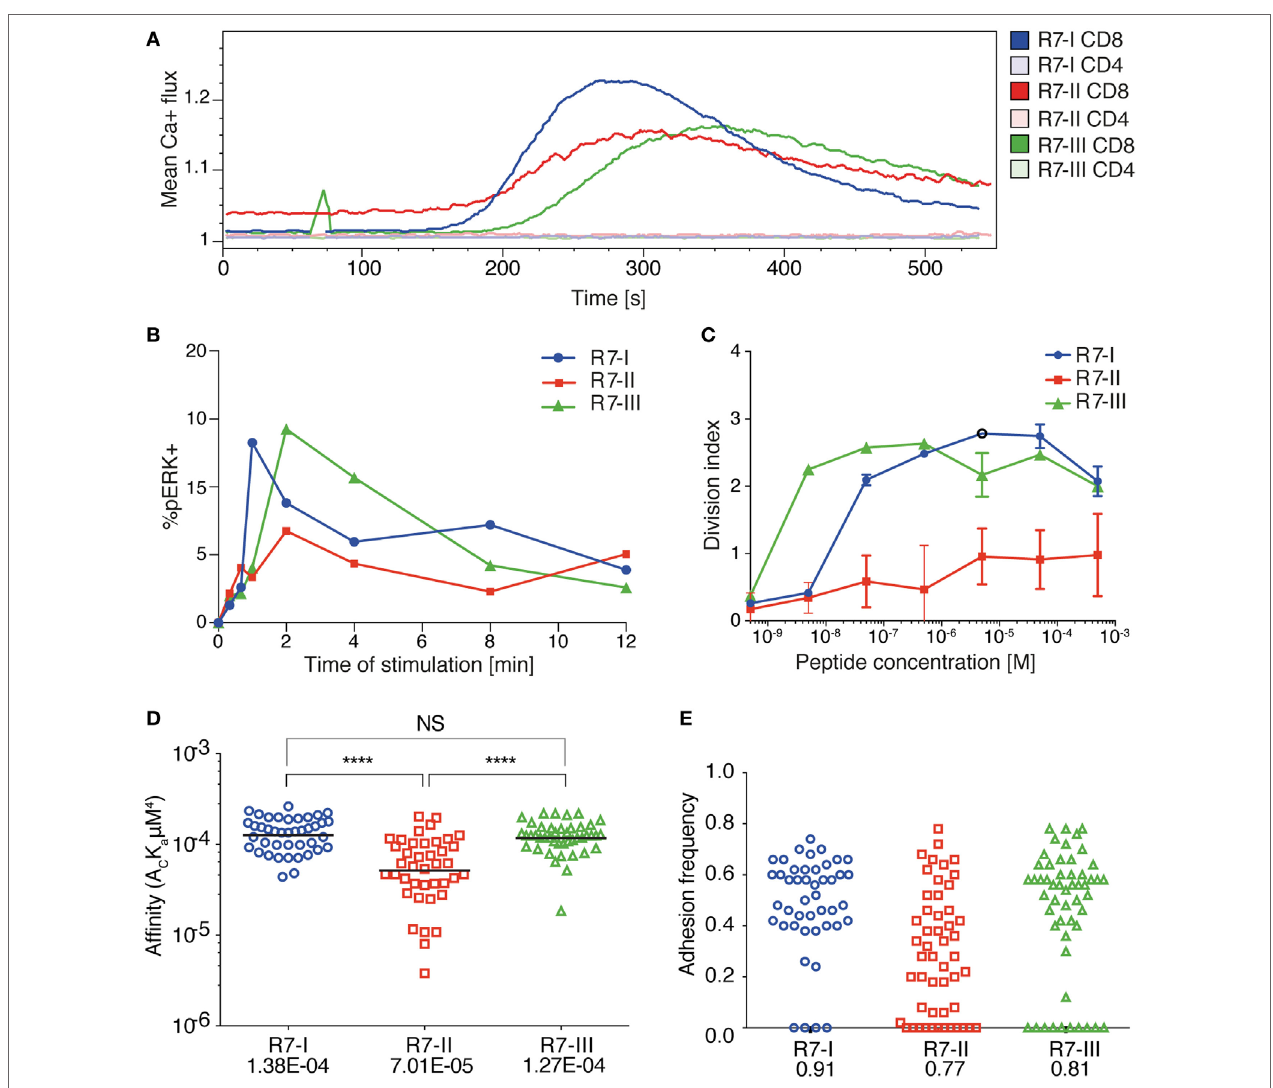
FigUre 1 | Three distinct CD8 T cell clones of the same specificity exhibit different 2D affinity and responses to specific TCR receptor stimulation. (a) Ca 2 + flux profile of the three R7 CD8 T cell lines upon stimulation of TCR signaling with ROP7 dextramer (representative of two experiments with multiple mice each). (B) Phosphorylation of ERK1/2 kinase in time upon stimulation with splenocytes loaded with ROP7 peptide (representative of two experiments). (c) Proliferation of R7 CD8 T cells after stimulation with a range of ROP7 peptide concentrations (representative of three experiments). (D) Relative 2D affinity of the three R7 CD8 T cell clones specific for ROP7 (IPAAAGRFF) normalized by TCR surface density. Each individual data point represents the affinity for a single CD8 T cell. Analysis utilizes the geometric mean of the population. (e) Adhesion frequencies of the three ROP7 clones F. Gaussian curves were fitted to the affinities of (D) . Blue line represents R7-I, red line represents R7-II, and the green line represents R7-III. Data are cumulative from two individual experiments and a total of three mice per